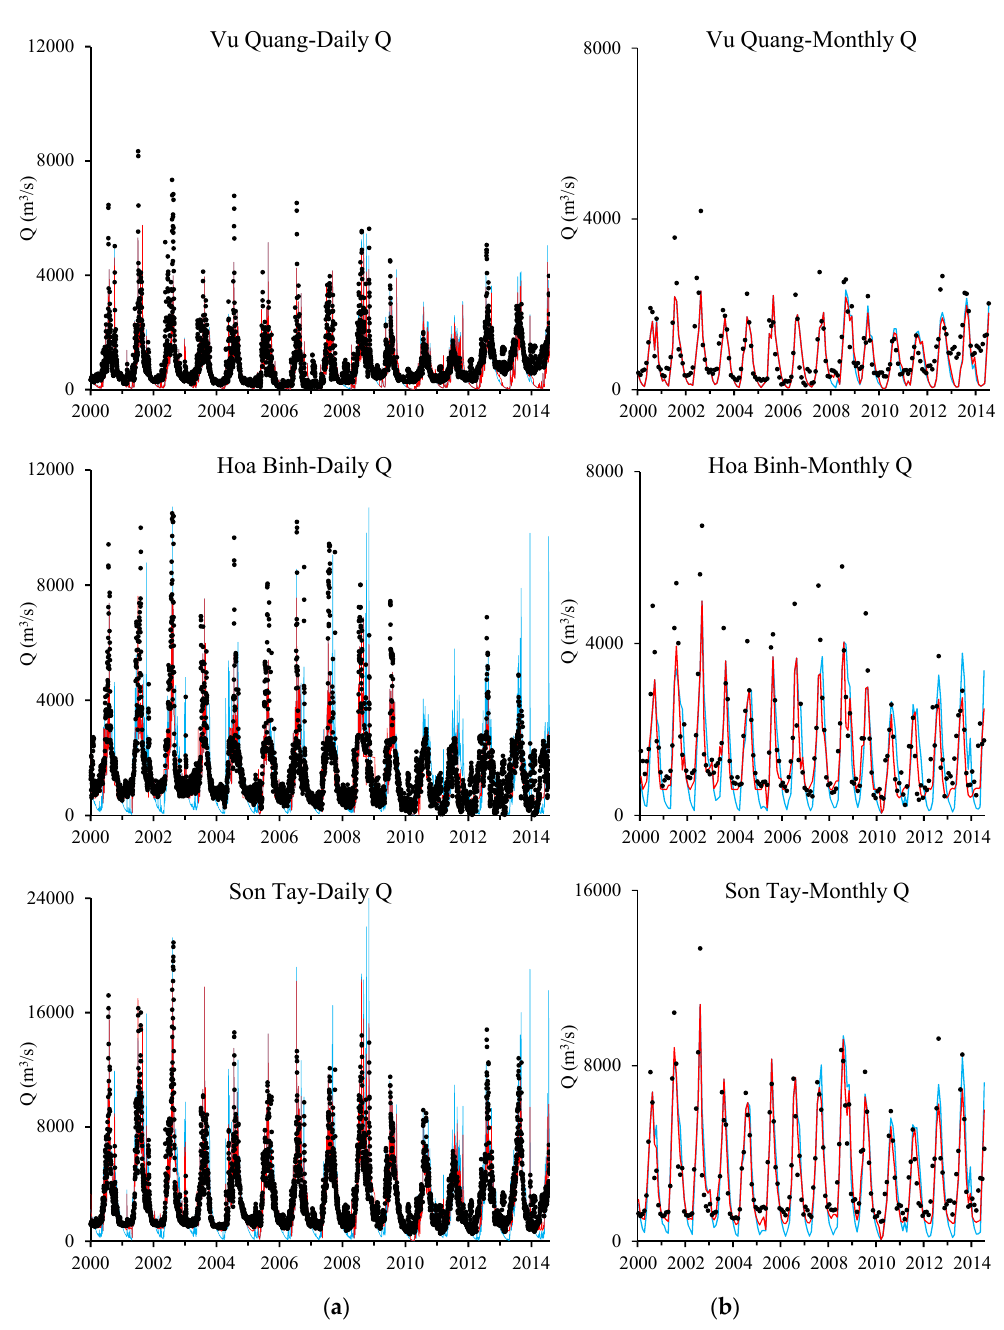
Figure 3. Observed (black dot) and actual simulated (red solid line) daily ( a ) and monthly ( b ) discharge (Q) at five stations from January 2000 to July 2014. Blue solid line represents the scenario simulation of Q under natural conditions.